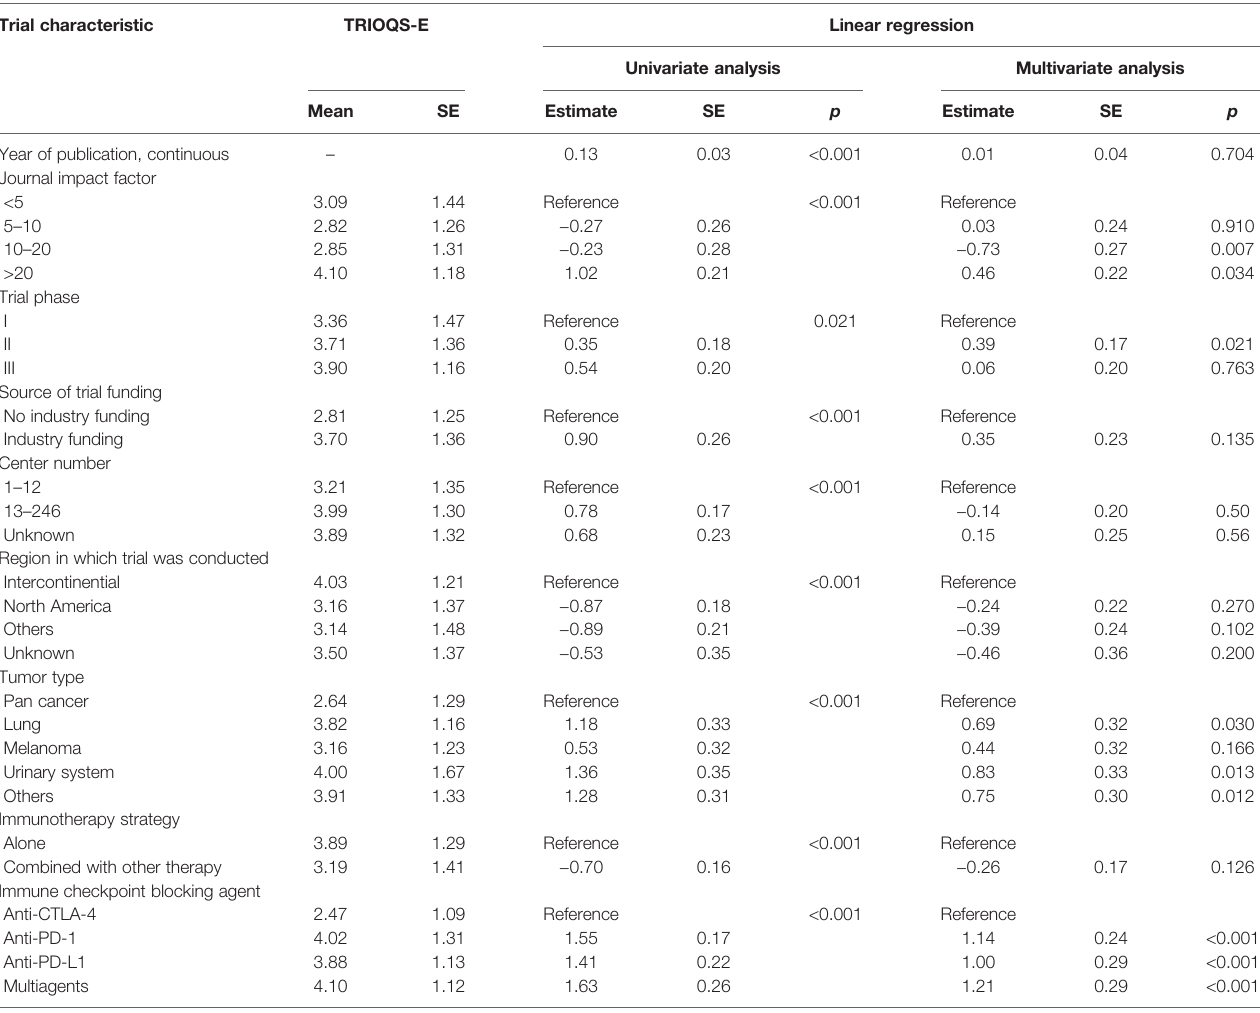
TABLE 4 | Results of linear regression analyses of trial characteristics predicting TRIOQS-E (0 – 6 scale). Trial